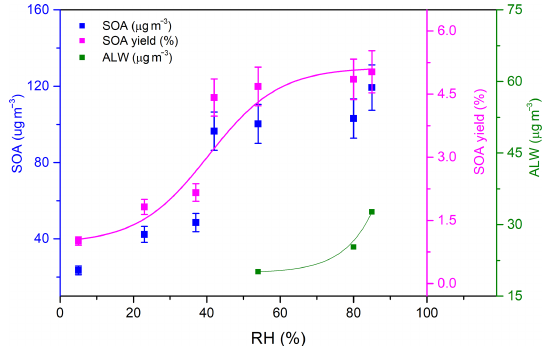
Figure 4. Dependences of the SOA mass concentration, SOA yield, and ALW on relative humidity